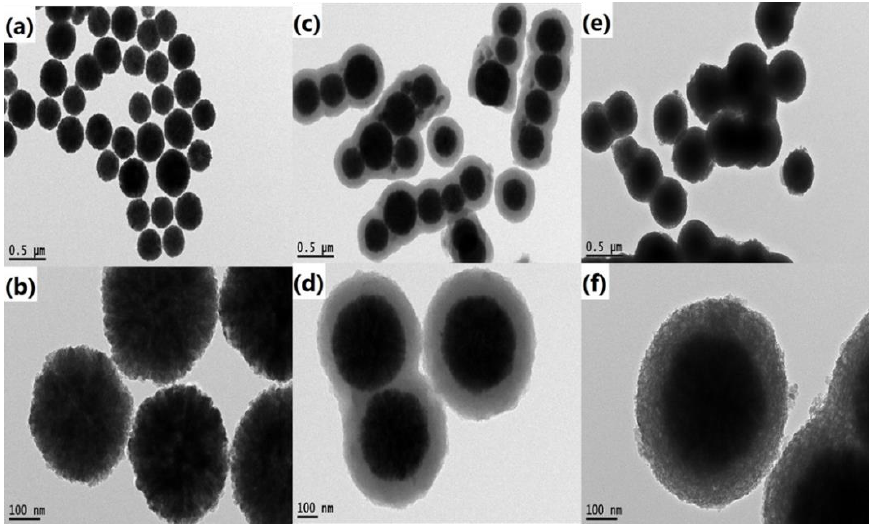
Figure 4. TEM images of Fe 3 O 4 microsphere ( a , b ), Fe 3 O 4 @MIL-100 (Fe) support ( c , d ) and the immobilized lipase ( e , f ).